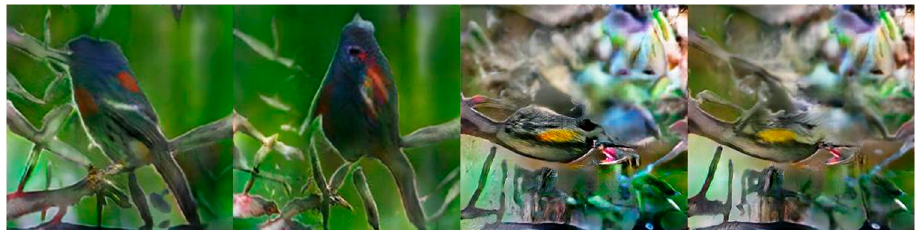
Figure 9. Example of mode collapse occurring in StackGAN.